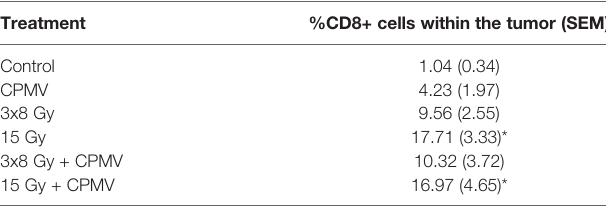
TABLE 3 | CD8+ Immune In fi ltration. The average CD8+ populations for each treatment type with the standard deviations also reported.